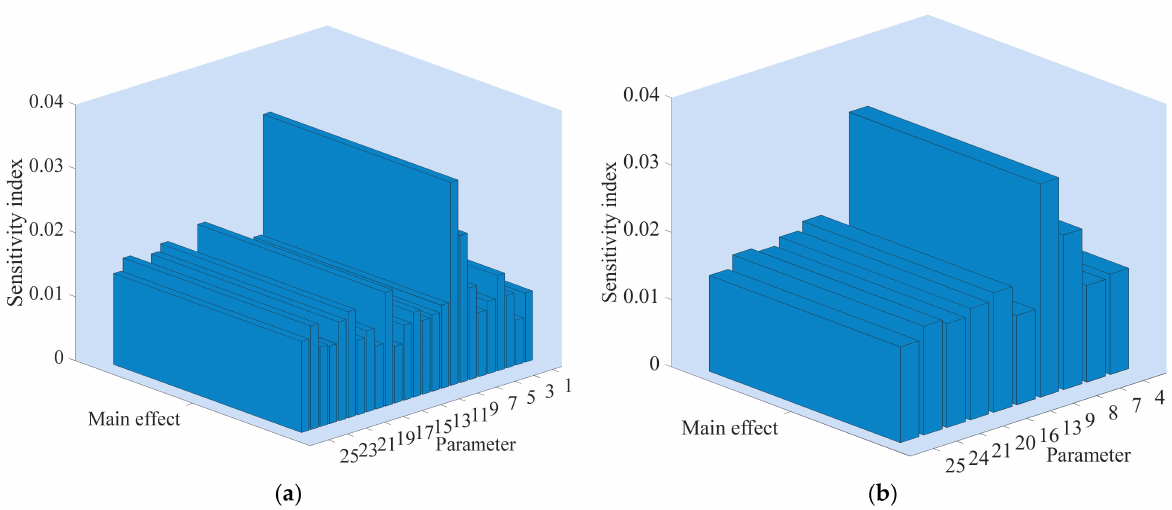
Figure 19. The sensitivity index of parameters of the overshoot of the angular velocity. ( a ) The sensitivity index of 25 parameters; ( b ) The sensitivity index of the top 10 parameters. The numbers 1 to 25 represent symbols T , Kp , b p , K d , A t , D t , f p , q nl , T 0 , T d0 , T d00 , T q00 , H , F , K a , R s , L ls , R r , L lr , L m , H 1 , F 1 , WS , Ncellm12 and I r , respectively. For the physical meaning and definitions of these parameters, see Appendix B. Table 6. Sensitivity index results of DPIs of angular velocity.